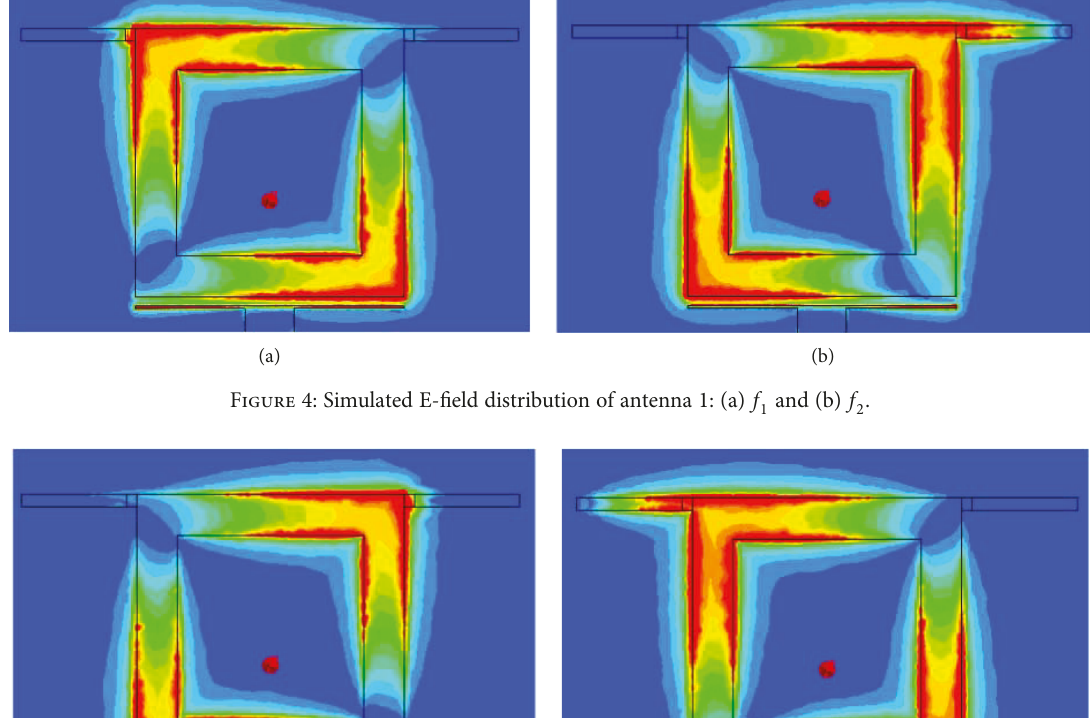
Figure 5: Simulated E- fi eld distribution of antenna 2: (a) f